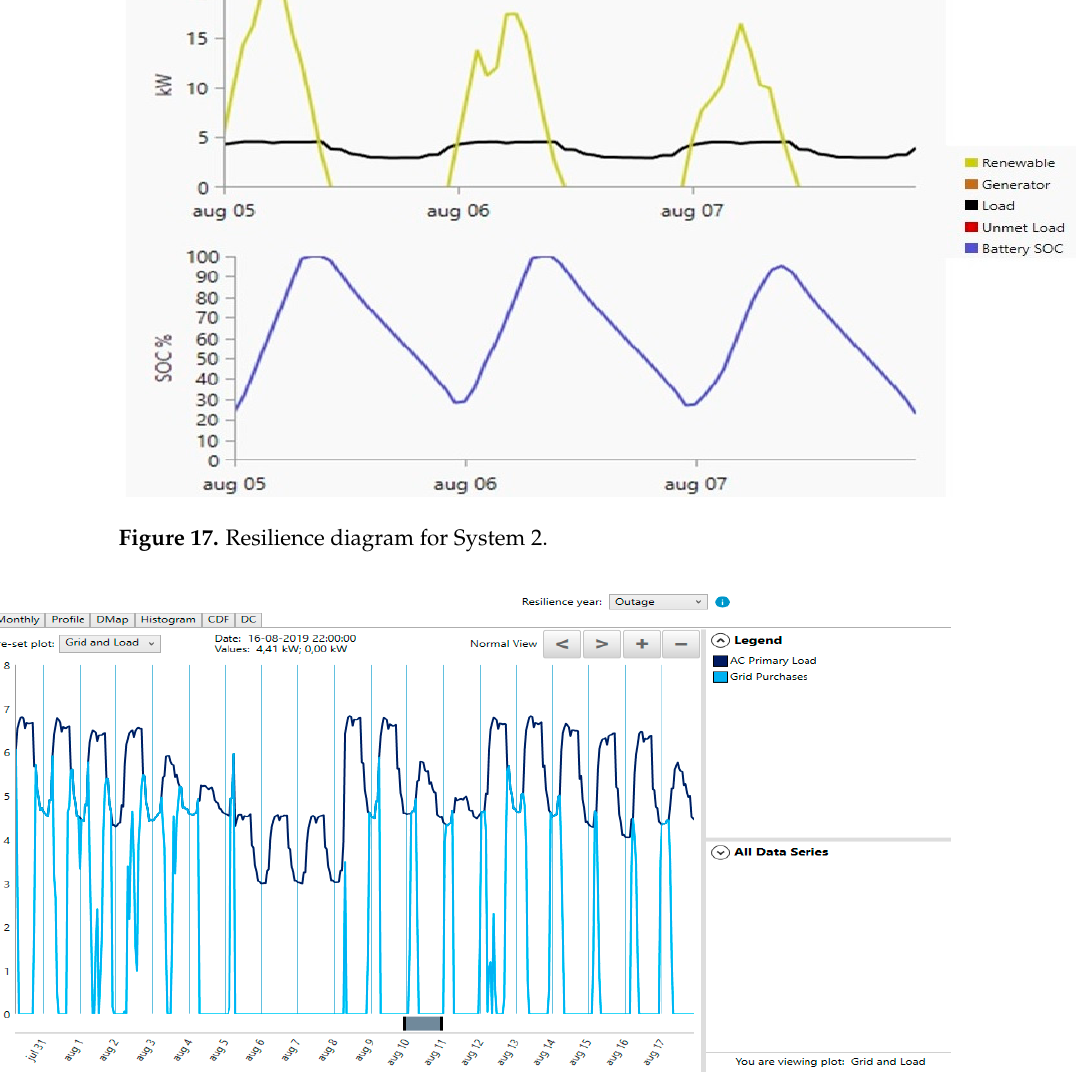
Figure 18. Grid and load for System 2 during an outage. Table 8. Parameters for SYSTEM